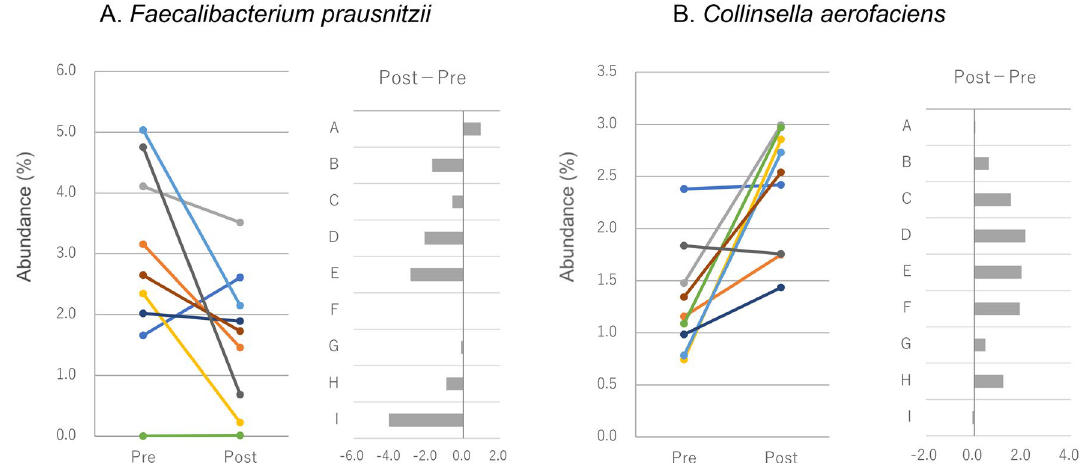
Figure 2. Changes in abundance (%) of Faecalibacterium prausnitzii ( A ) and Collinsella aerofaciens ( B ) before (Pre) and after (Post) the